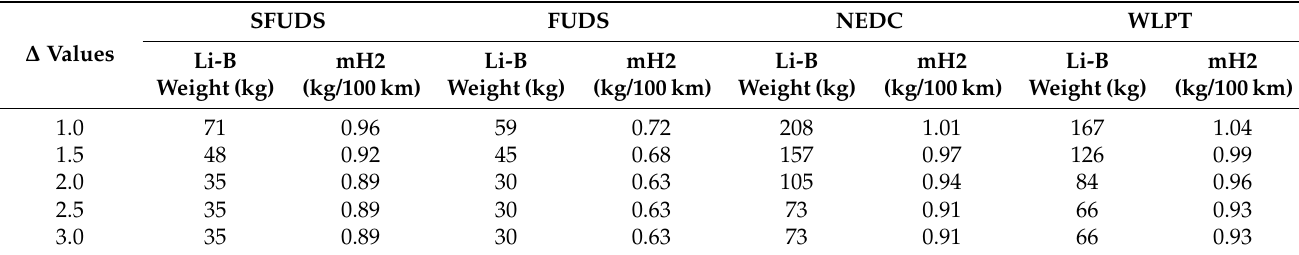
Table 6. Effect of δ on the sizing procedure (Psplit1).